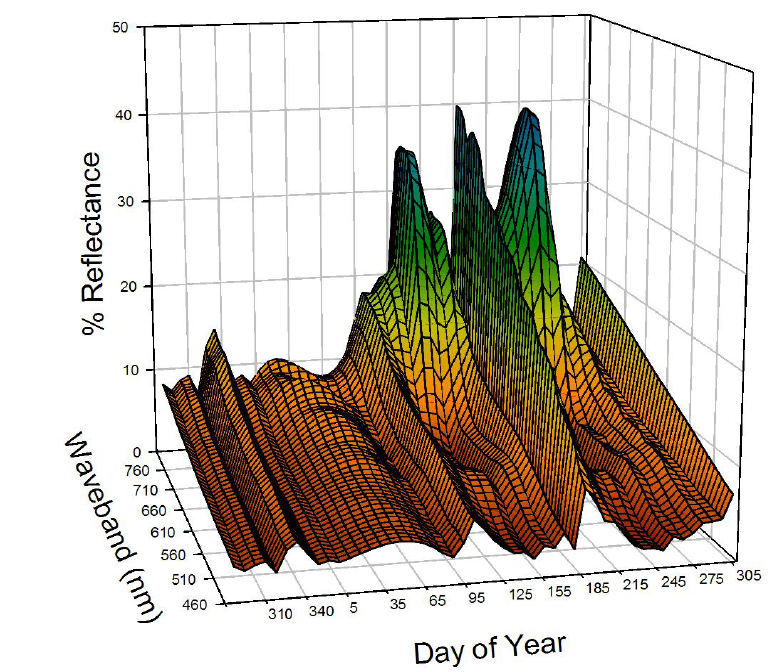
Figure 4. Reflectance over wheat (until DOY 180) and soybean (DOY 180 and greater) obtained throughout the 2006–2007 year with a CropScan eight-band